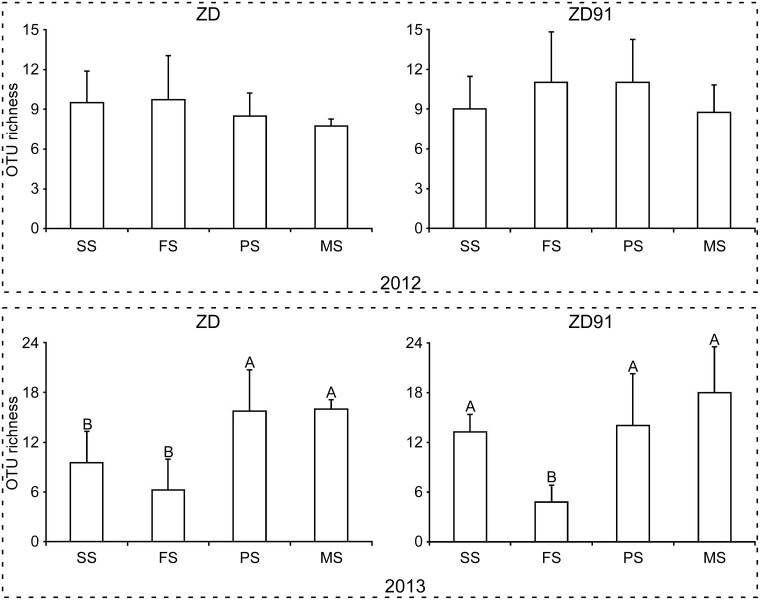
AM fungal OTU richness in soil.The letter above the column indicates significant differences in the richness of AM fungal OTUs among the four growth stages (P < 0.01). SS: seedling stage; FS: flowering stage; PS: pod-setting stage; MS: maturity-setting stage.